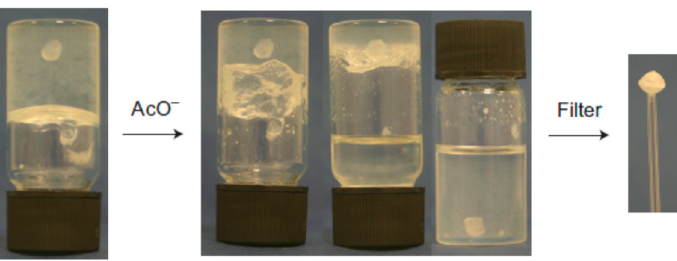
Chart 7. Compounds used for supramolecular gel phase crystallization.